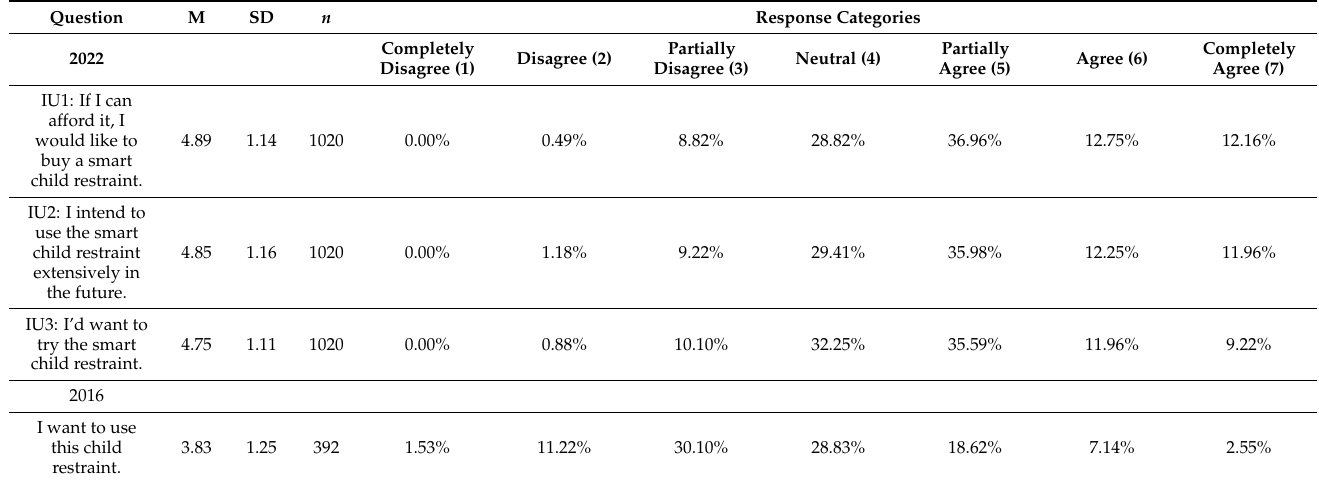
Table 2. Respondents’ acceptance of child safety seats was compared.